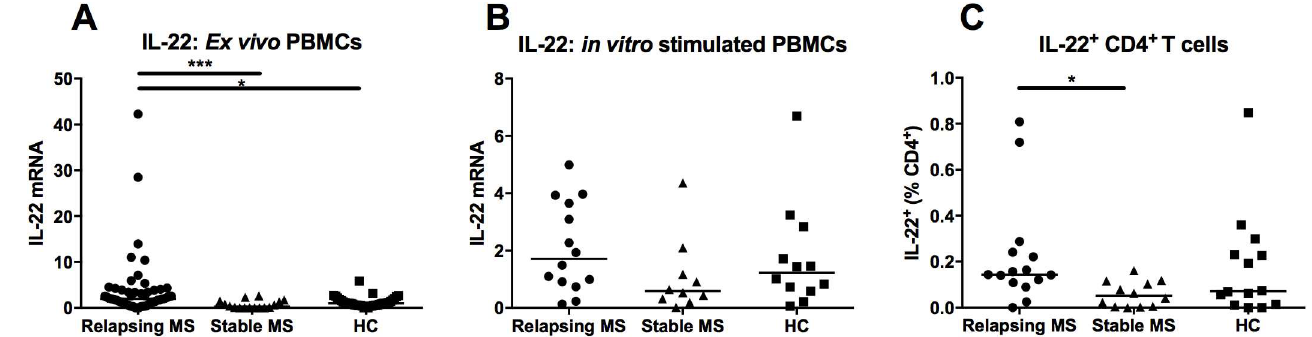
Fig 2. IL-22 mRNA and IL-22-producing cells in PBMCs from relapsing and stable MS patients and from healthy controls (HC). Quantitative- PCR to measureIL-22 mRNA expression(A) ex vivo (Relapsing MS: n = 56, Stable MS: n = 16, HC: n = 37) and (B) after 4h of stimulationby PMA/ ionomycin(Relapsing MS: n = 14, Stable MS: n = 10, HC: n = 12). (C) PBMCs were stainedfor IL-22, CD3 and CD4 after 4h stimulationby PMA/ ionomycinin the presenceof a protein transport inhibitorand analysedby flow cytometry (Relapsing MS: n = 15, Stable MS: n = 12, HC: n = 14). Scatter dot plot shows the percentage of IL-22 + CD4 + T cells. The horizontal lines of scatter plots represent the medianvalue in all subgroups. * and *** indicate respectivelyp-values (cid:20) 0.05 and (cid:20) 0.001.